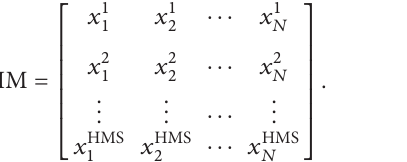
Figure 1: The flowchart of the HS